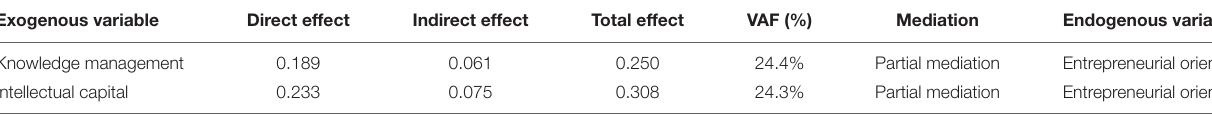
TABLE 7 | Mediation analysis (entrepreneurial orientation as a mediator).